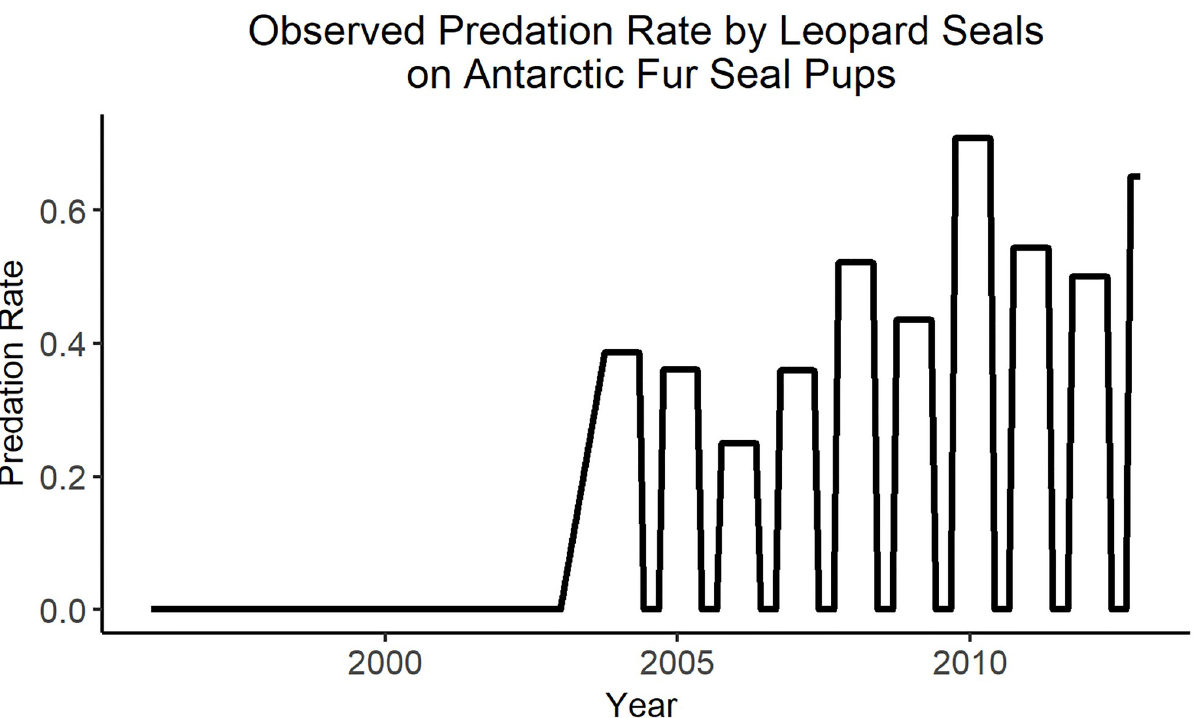
Fig 6. Observed leopard seal predation rate on Antarctic fur seal pups. Figure recreated from Goebel and Reiss [53].